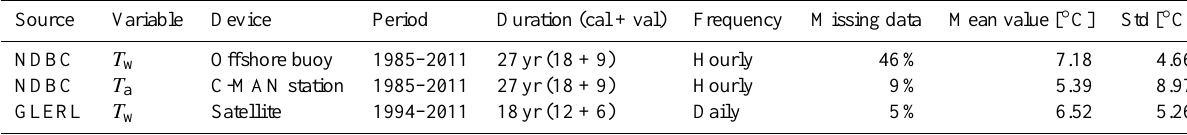
Table 1. Summary of the datasets adopted in this study, and their main